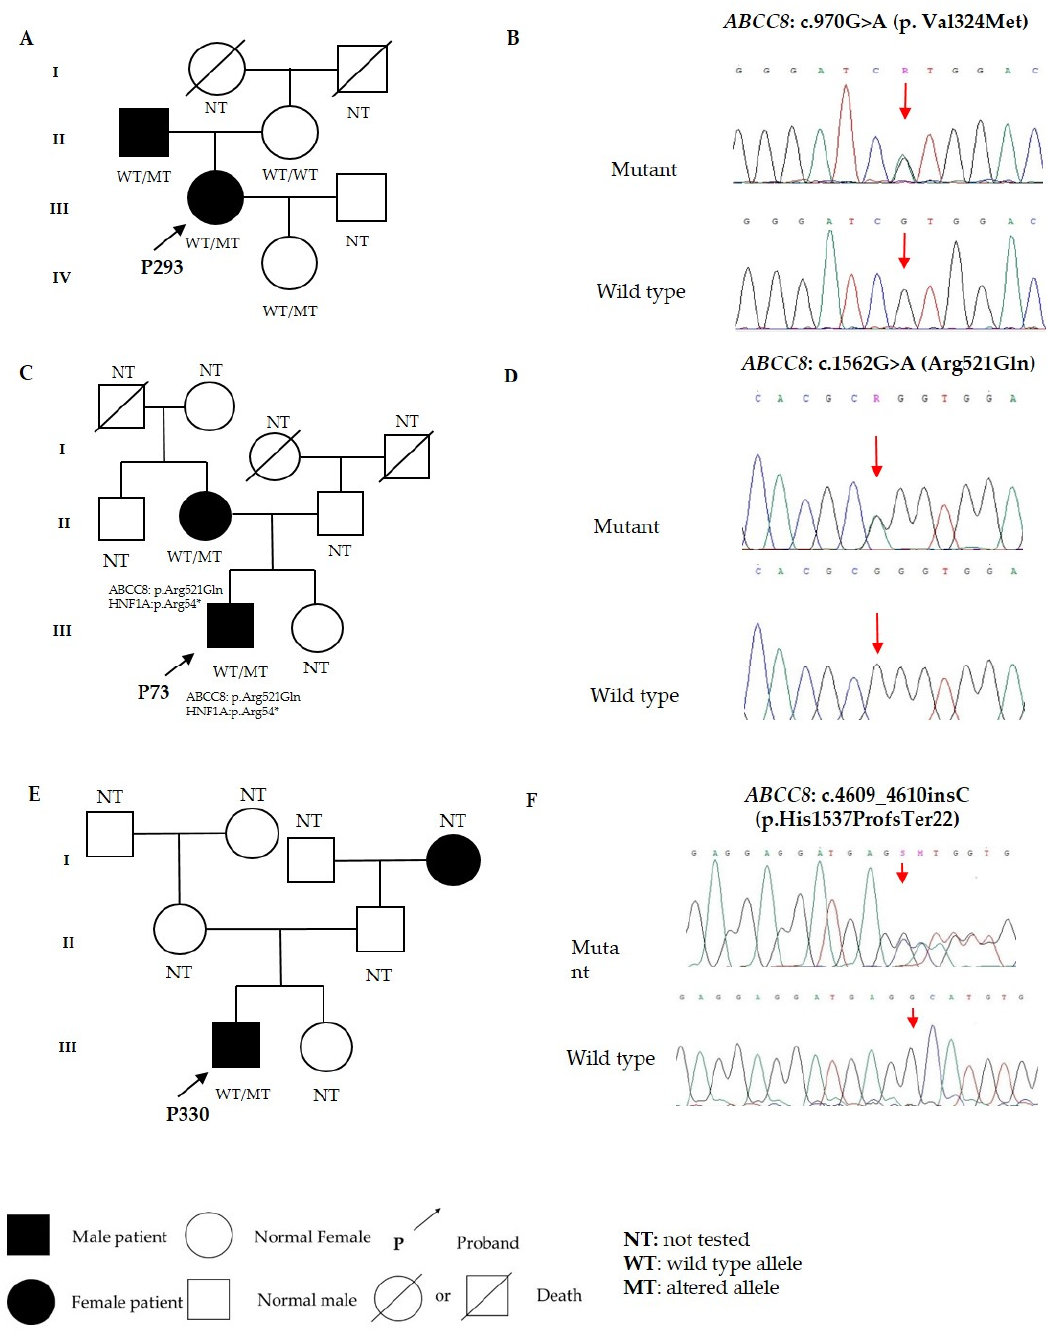
Figure 1. The screened families with identified variants. ( A , B ) c.970G>A (p.Val324Met), ( C , D ) c.1562G>A (p.Arg521Gln), and ( E , F ) c.4609_4610insC (p.His1537Profs*22) in the ABCC8 gene. Heterozygous missense mutation c.970G>A (p.Val324Met) in ABCC8 was identified